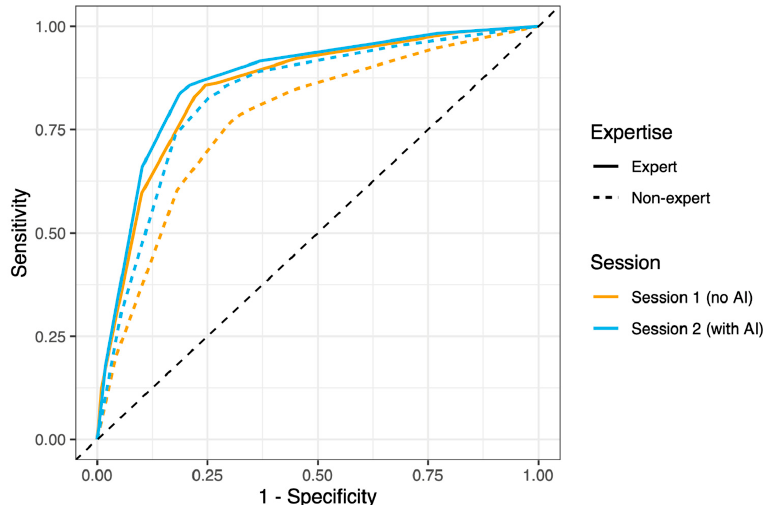
Figure 4. ROC curves for optical characterization performed by experts and non-experts, with and without the help of GI Genius CADx. Solid lines represent experts, dotted lines represent non-experts, orange color represent the session without AI, and the blue color represents the session with AI. The figure is from the supplementary materials of Reverberi et al. [20].